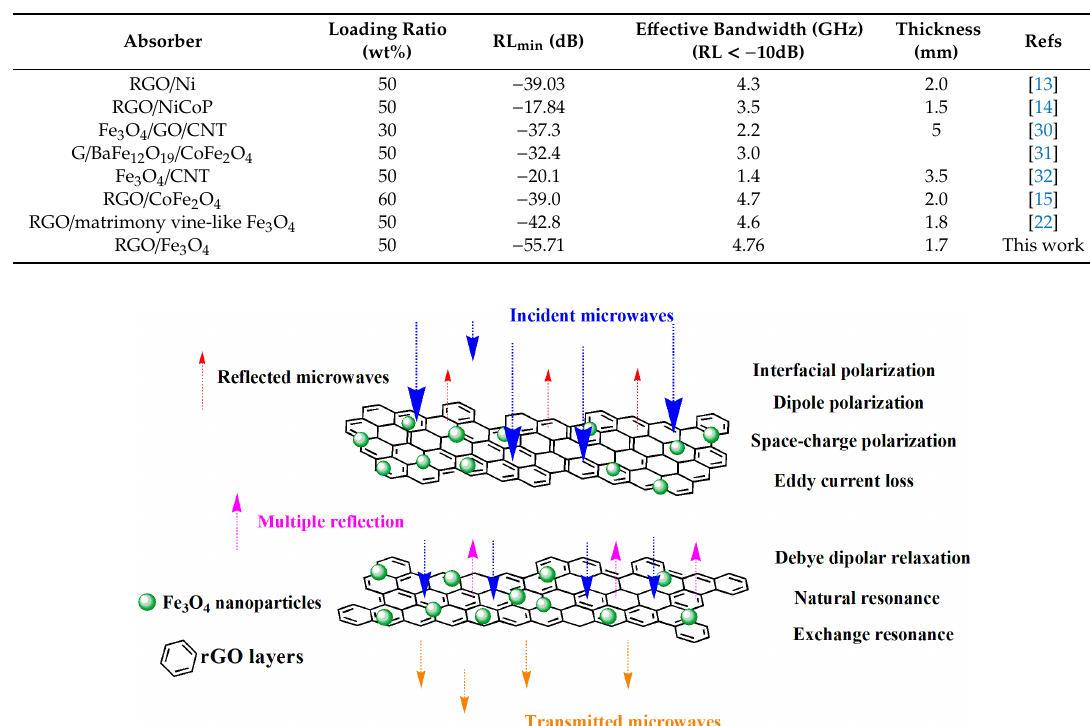
Table 1. Comparison of microwave absorption properties in this work and other representative works.